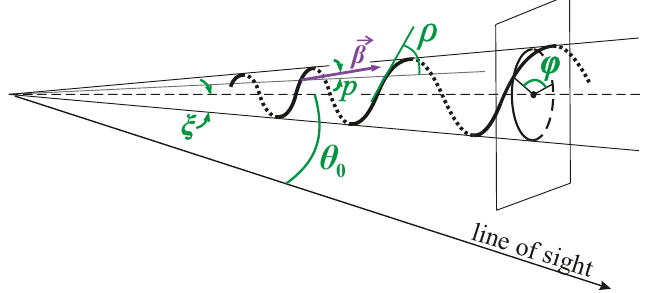
Figure 1. Scheme of a helical jet with the specified model parameters: The cone axis is shown by the dashed line. The thin solid line displays the cone generatrix. The thick line denotes the jet. The dotted line refers to those parts of the jet which are located opposite to the observer side of the